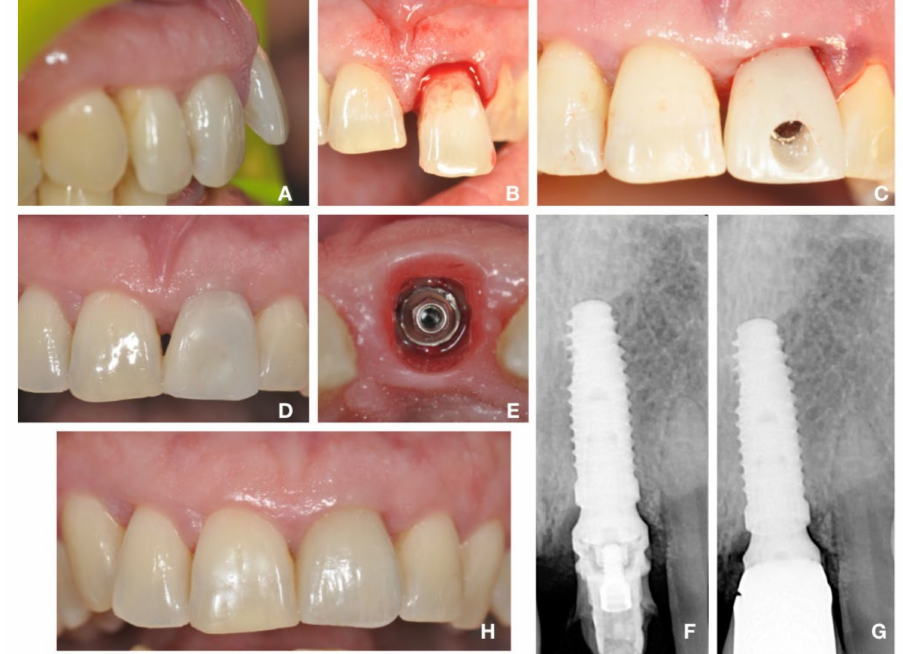
Figure 1. Single restoration in fresh extraction socket, immediately loaded with temporary abutment and prosthesis. ( A ) Clinical situation before the extraction of tooth 2.1. ( B ) Extraction of the hopeless tooth 2.1. ( C ) Implant insertion under the bone crest level, according to the mathematical rule (a low profile MUA was contextually positioned and immediately loaded with a temporary crown). Clinical evaluation after 60 days, showing excellent soft tissue healing around the temporary crown ( D ) and the implant ( E ). Radiographic evaluation after 60 days ( F ) and after 5 years follow-up ( G ), showing no bone resorption around implant. ( H ) Clinical evaluation after 5 years